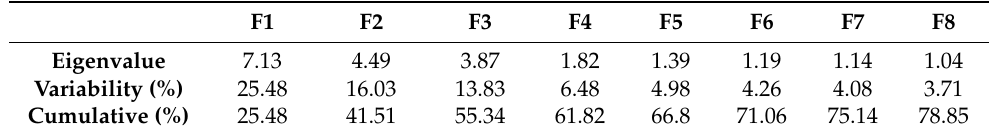
Table 2. Eigenvalues for the first eight most significant components (F1–F8) of the principal compo- nent analysis (PCA) for 37 sesame